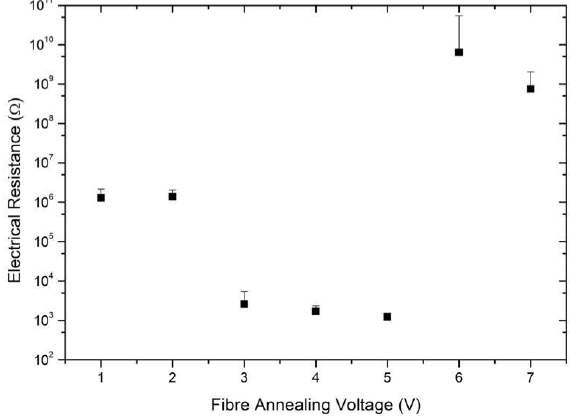
Figure 5. A semi-log plot of CNT fiber average electrical resistance as a function of annealing voltage in the nanoprobe. Electrical resistance drops to a minimum point followed by an irreversible in- crease.